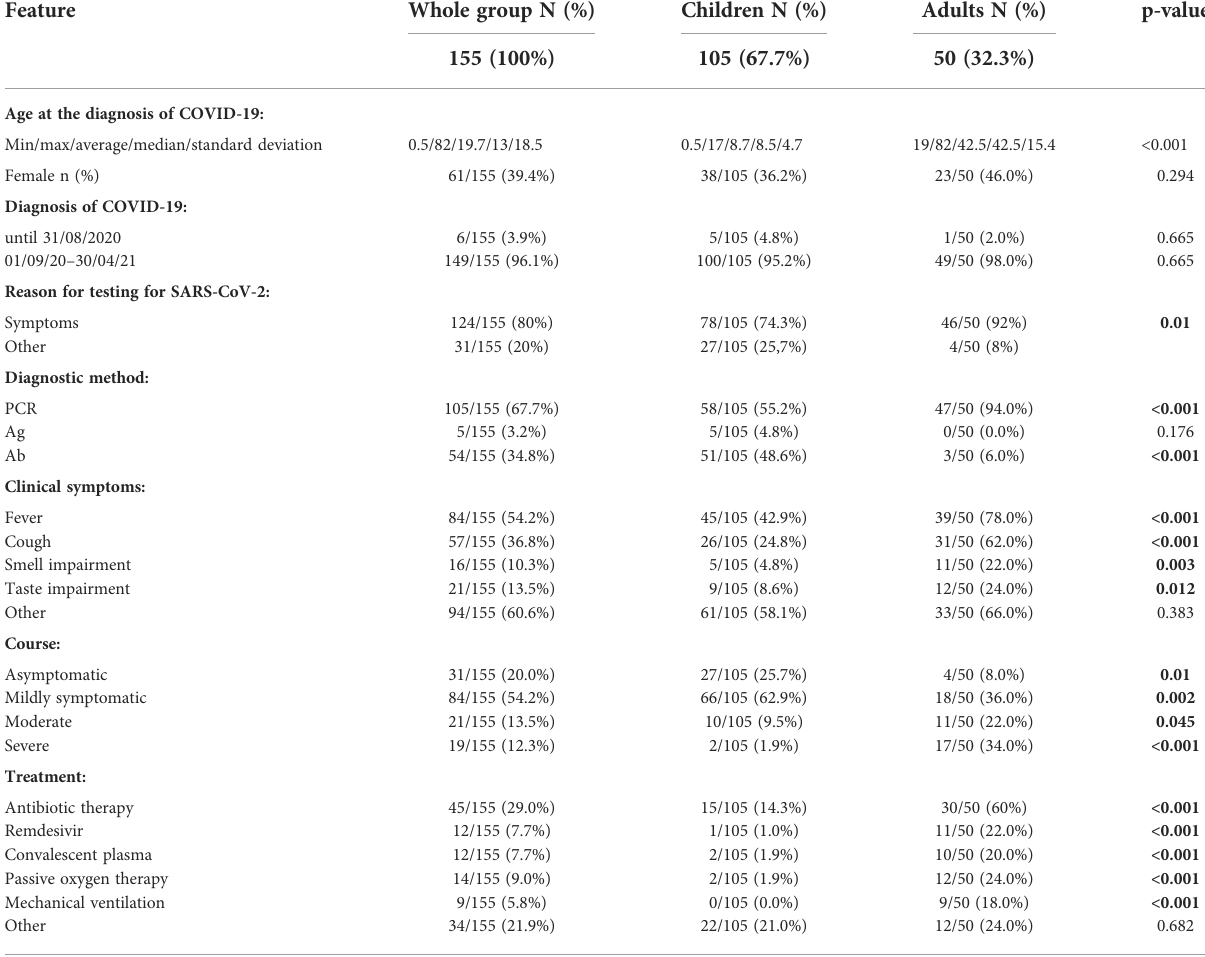
TABLE 3 The results of research on COVID-19 infection in patients with